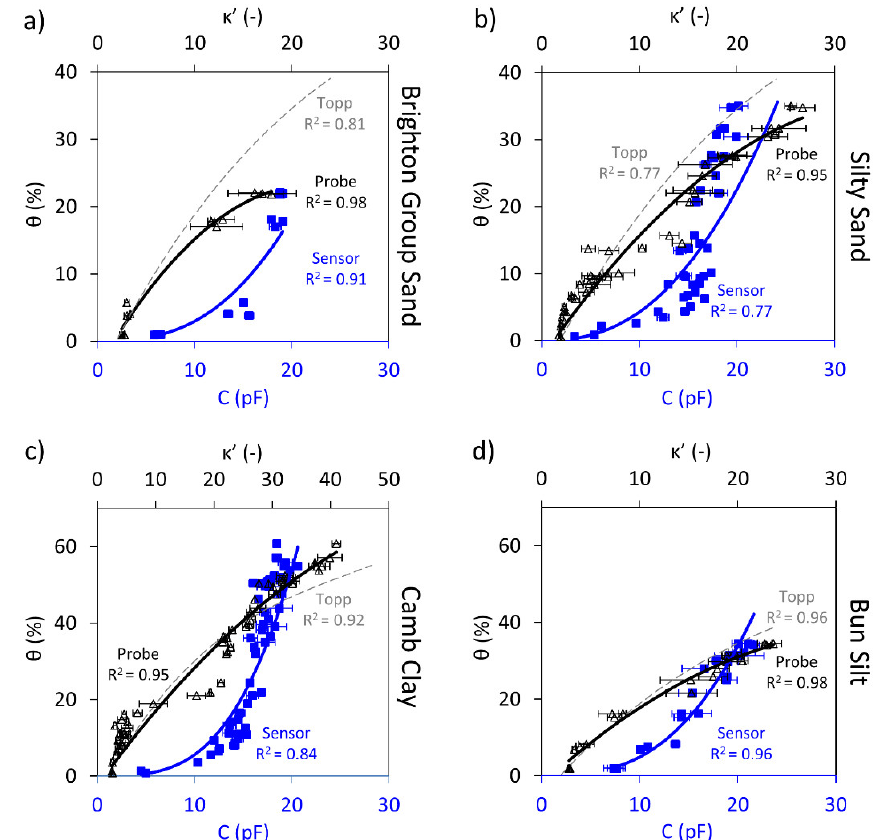
Figure 5. PCB sensor capacitance, C, readings (blue square markers and trendline) and dielectric constant, κ’, measurements (black triangular markers and trendline) shown against the volumetric water content, θ; the Topp equation is also shown (dashed grey trendline). Shown for: ( a ) Brighton Group Sand ( b ) Silty Sand ( c ) Camb Clay and ( d ) Bun Silt.